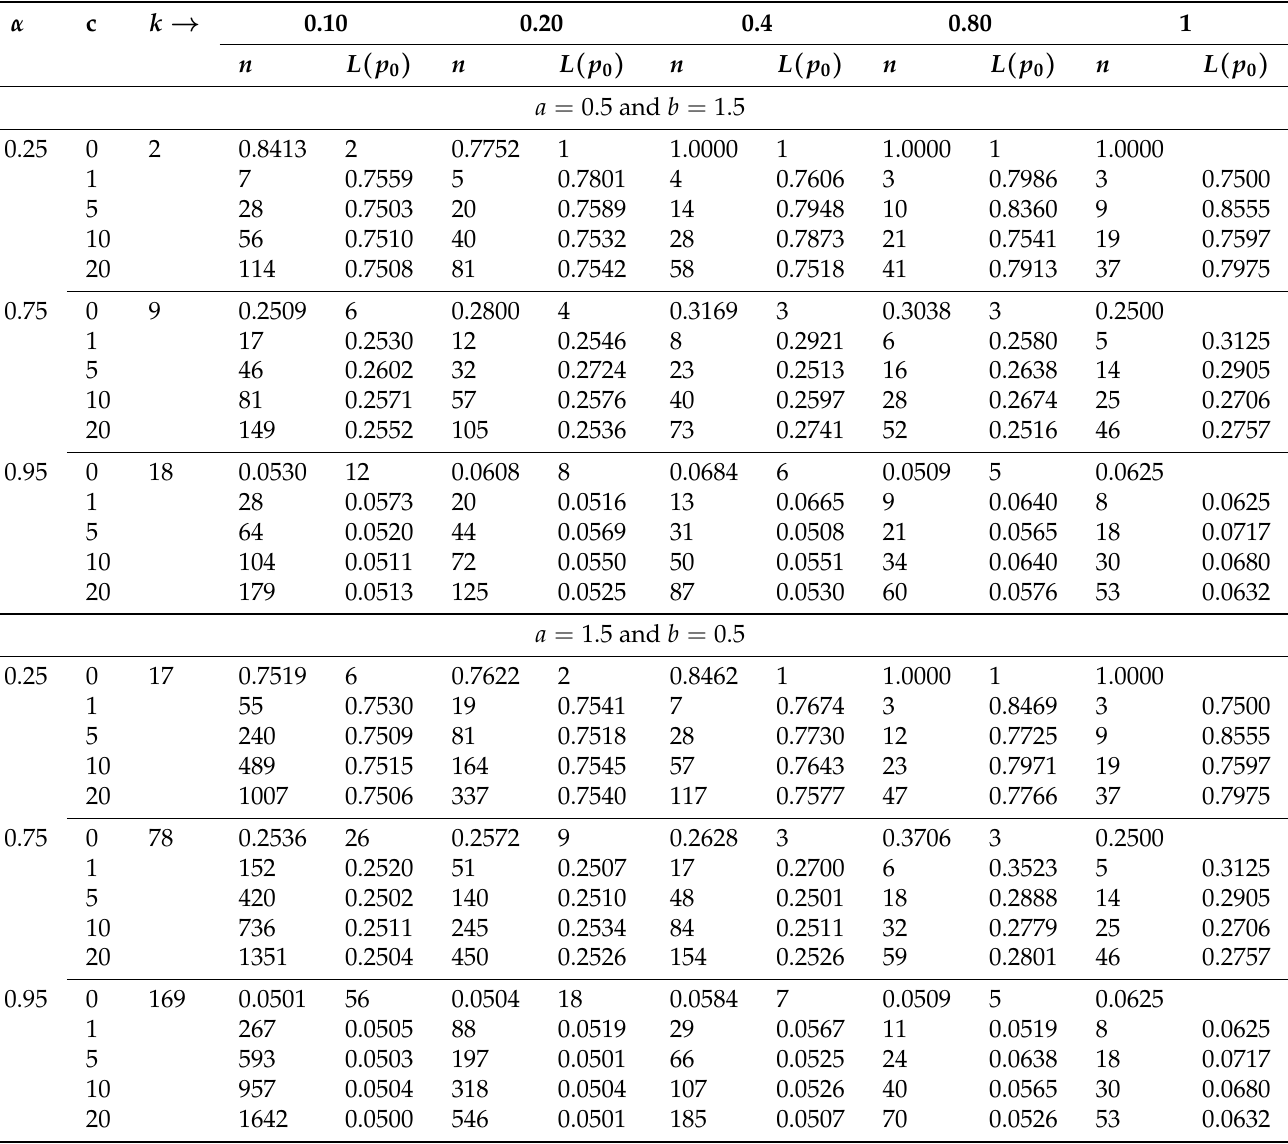
Table 4. ASPs for the BBE 2 distribution with parameters: λ = 0.5, θ = 0.75 and different values for a and b